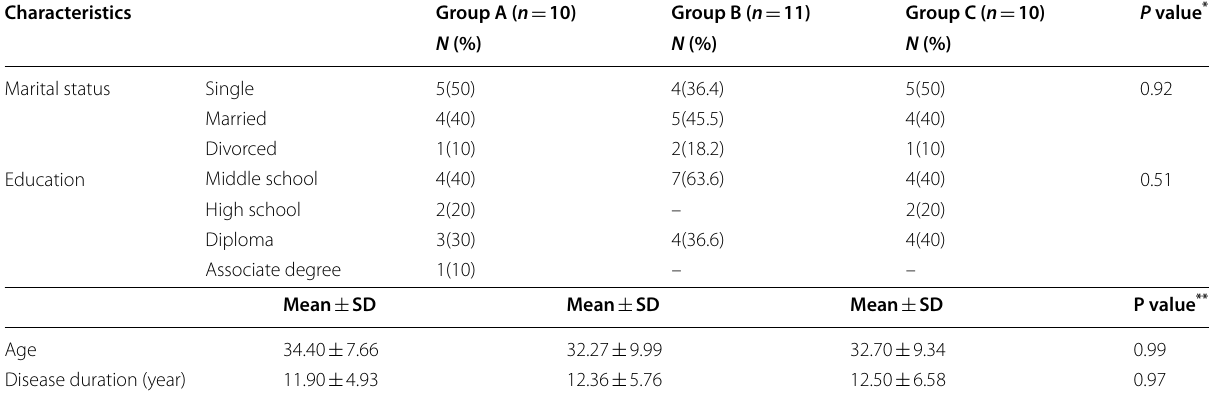
*Chi-square test, **One-way ANOVA